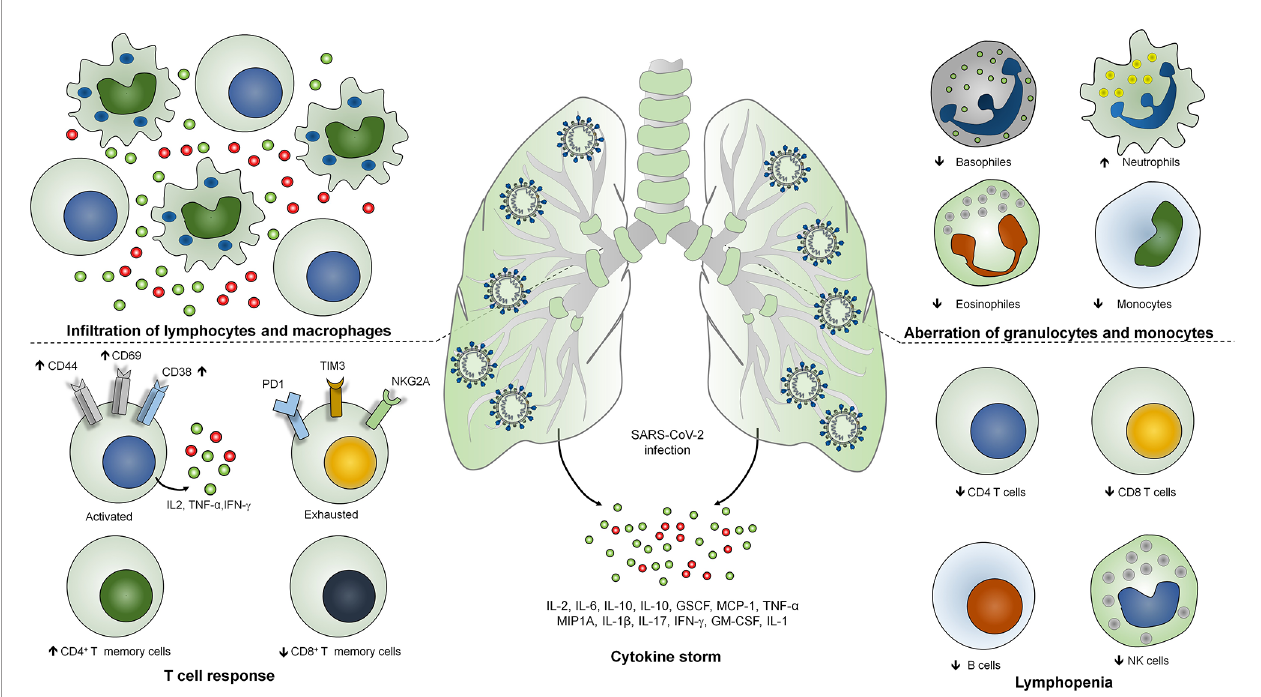
FIGURE 1 | Immunopathogenesis of SARS-COV-2 infection. Severe COVID-19 is identi fi ed with in fi ltration of lymphocytes and macrophages in the lungs, lymphopenia or lymphocytopenia where reduction in the number of CD4 + , CD8 + T cells, B cells and NK cells occurs. SARS-CoV-2 infection is identi fi ed with the lymphocyte activation with increased expression of CD38, CD69 and CD44 activation markers and T cell exhaustion identi fi ed as T cell immunoglobulin domain and mucin domain-3 (TIM3), programmed cell death protein-1 (PD1), and killer cell lectin-like receptor subfamily C member 1 (NKG2A) markers. Level of neutrophils is strikingly higher whereas the level of monocytes, eosinophils and basophiles has been found to be reduced. Severe COVID-19 patients have been shown to exhibits higher levels of IL-2, IL-6, IL-10, IL-1, GSCF, MCP-1, TNF- a , MIP1A, IFN- g , IL-1 and